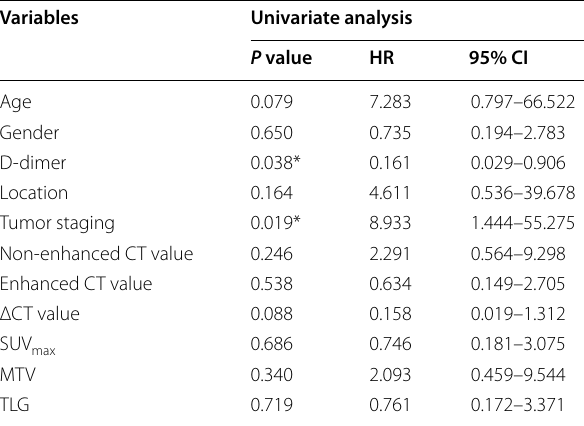
Table 3 Univariate Cox proportional hazards regression for OS in the patients with PAS